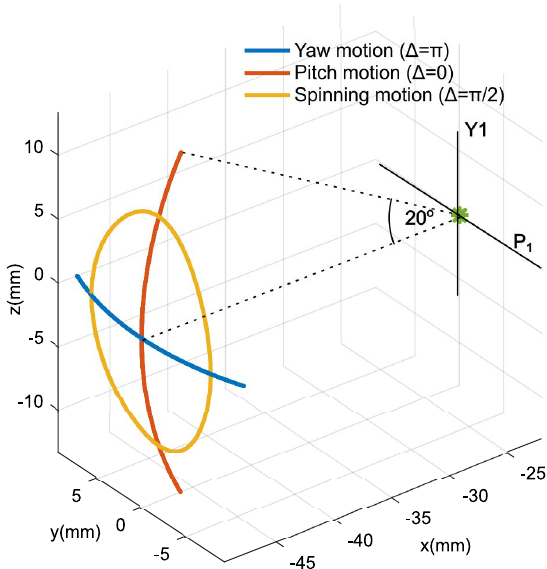
Fig. 7 Workspace and trajectories of T 1 corresponding to the coordinate frame in Fig. 6 for the joint angle ranging from 0 o to ± 20 o with respect to the centre of the P 1 − Y 1 universal